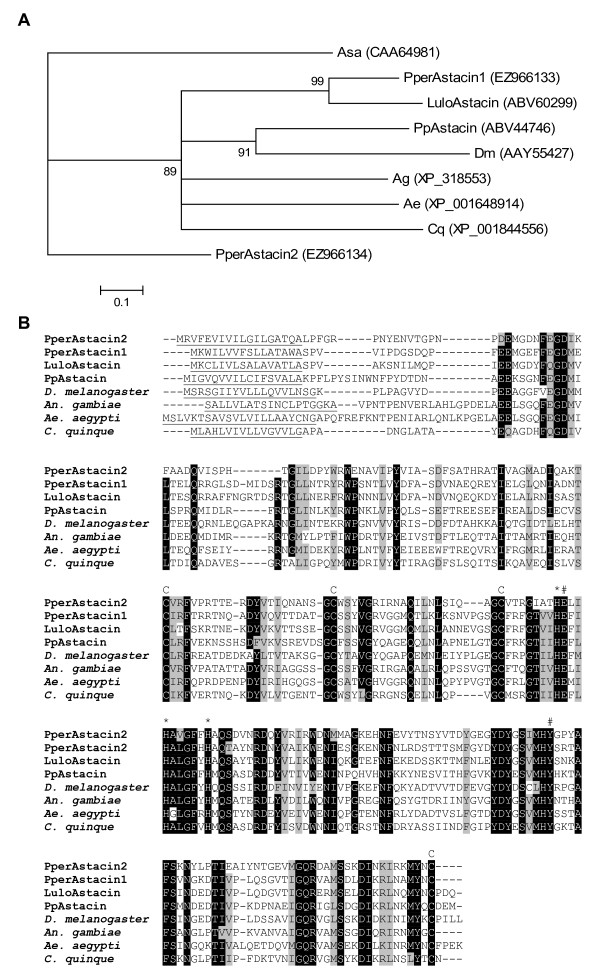
Phylogenetic analysis and sequence alignment of (putative) astacins. (A) Astacus astacus (Asa), Drosophila melanogaster (Dm), Aedes aegypti (Ae), Anopheles gambiae (Ag), Phlebotomus perniciosus (Pper), Lutzomyia longipalpis (Lulo), Phlebotomus papatasi (Pp) and Culex quinquefasciatus (Cq). Accession numbers are given in parentheses and node support is indicated by the bootstrap values. (B) Drosophila melanogaster (D. melanogaster), Aedes aegypti (A. aegypti), Anopheles gambiae (A. gambiae), Phlebotomus perniciosus (Pper), Lutzomyia longipalpis (Lulo), Phlebotomus papatasi (Pp) and Culex quinquefasciatus (C. quinque). Predicted signal peptide is underlined, conserved cysteines are indicated (C), the metal binding residues marked by (*) and catalytic residues marked by (#). Accession numbers: PperAstacin2 [GenBank:ABV44746], PperAstacin1 [GenBank:EZ966133], LuloAstacin [GenBank:ABV60299], PpAstacin [GenBank:ABV44746], D. melanogaster [GenBank:AAY55427], A. gambiae [GenBank:XP_318553], A. aegypti [GenBank:XP_001648914], C. quinque [GenBank:XP 001844556].